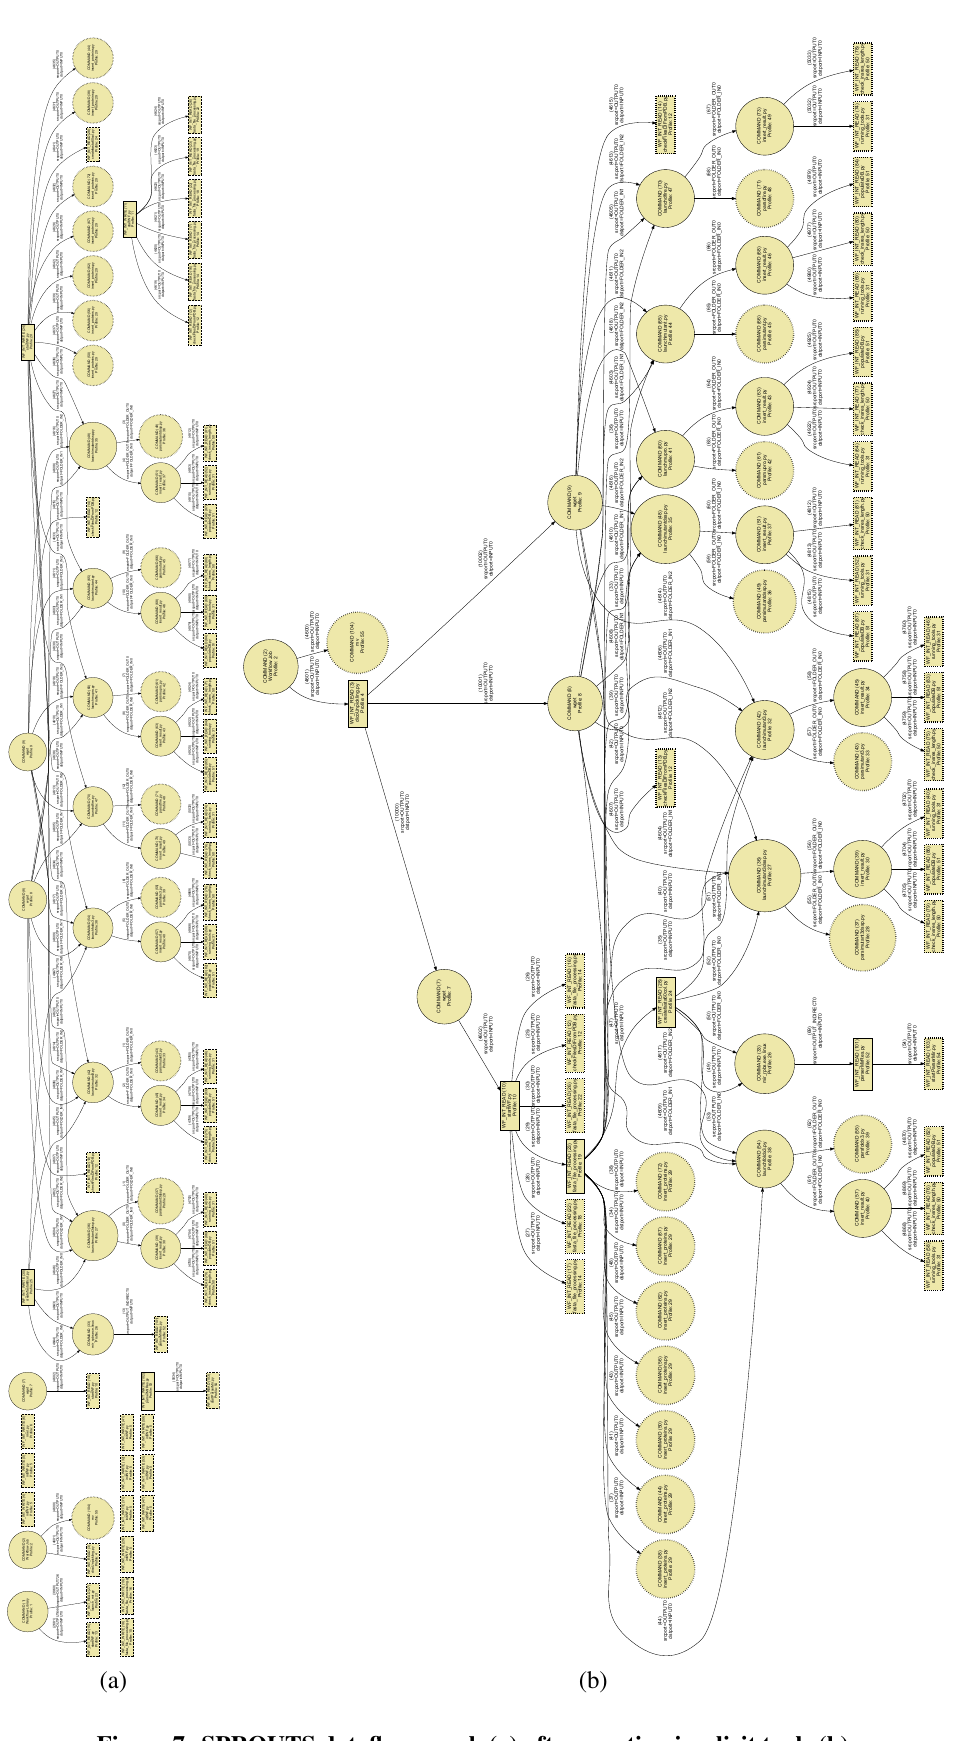
Figure 7: SPROUTS dataflow graph (a) after creating implicit tools